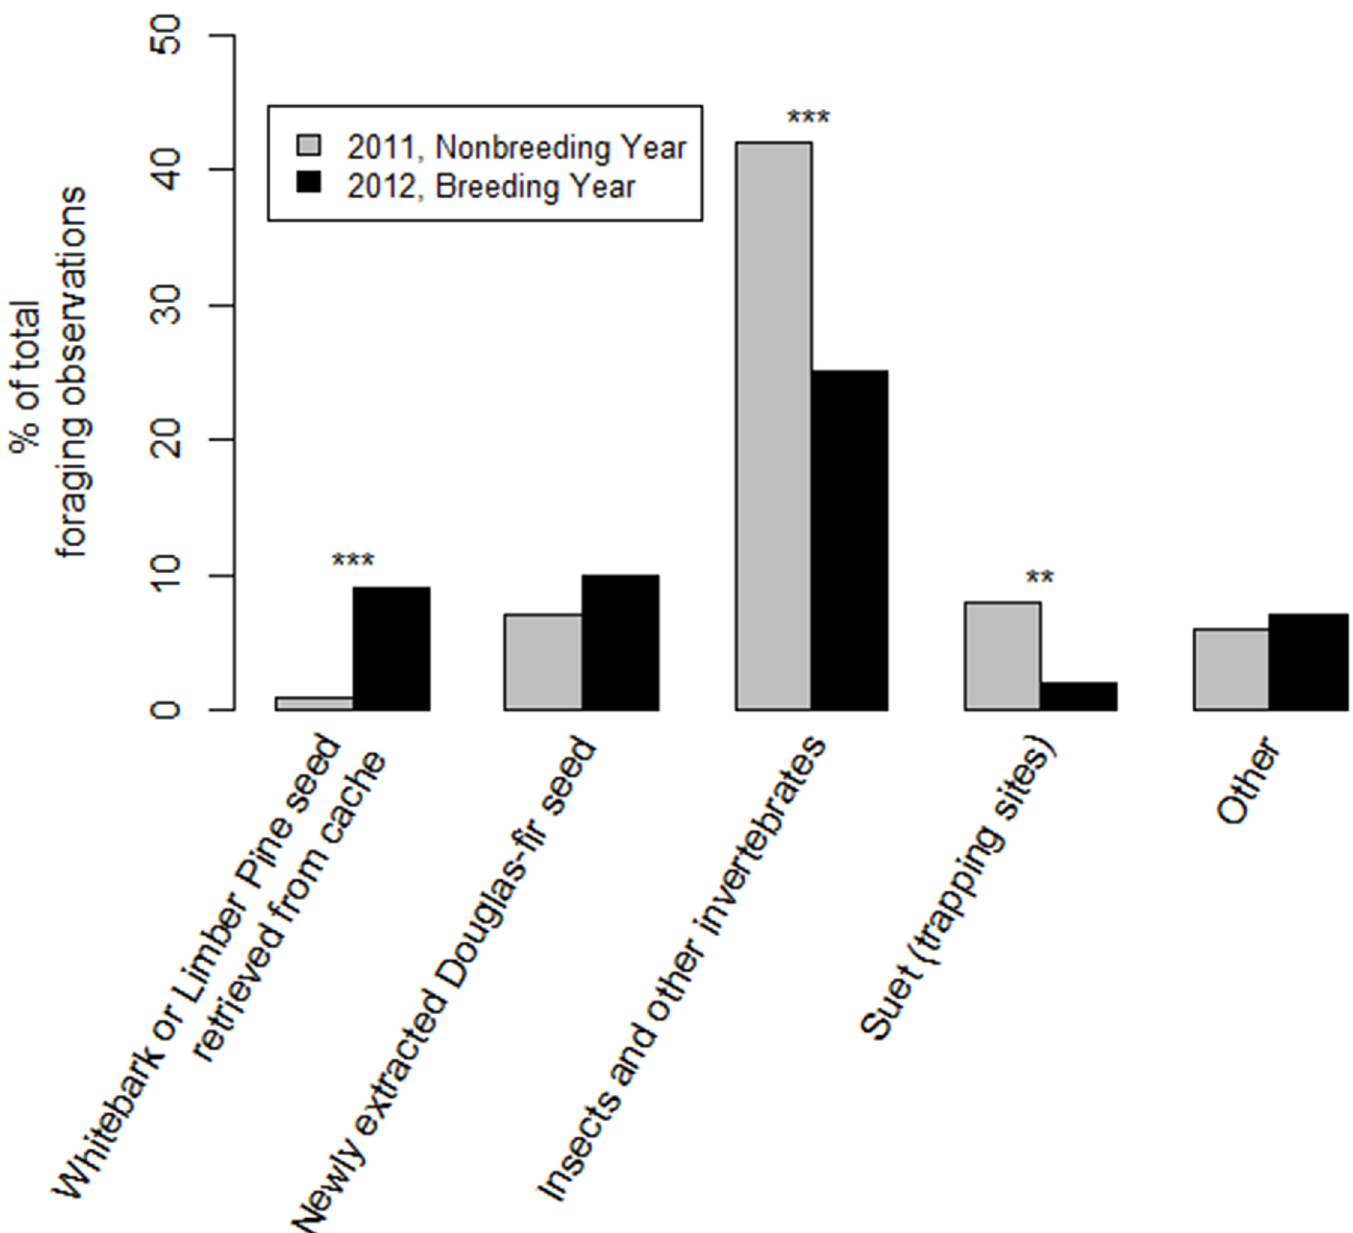
Fig 5. Food types. Percentage of known food types eaten during independent foraging events. Numbers do not add up to 100, as foods consumed during < 2.5% of the events, and unknown food items are not included in the